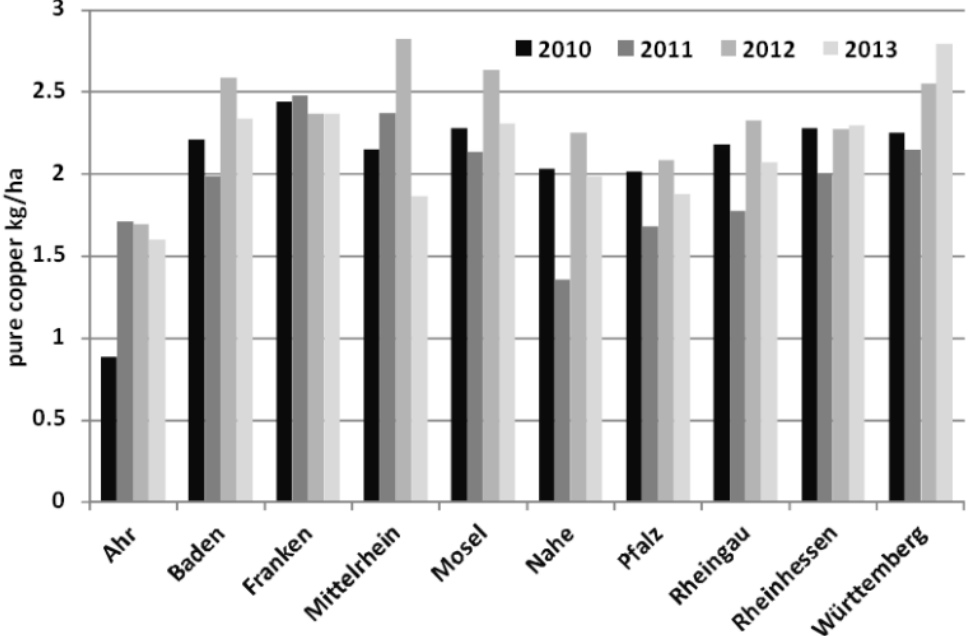
Figure 1. Average copper application rates [pure copper kg ha − 1 ] in organic viticulture by growing region in Germany from 2010 to 2013.